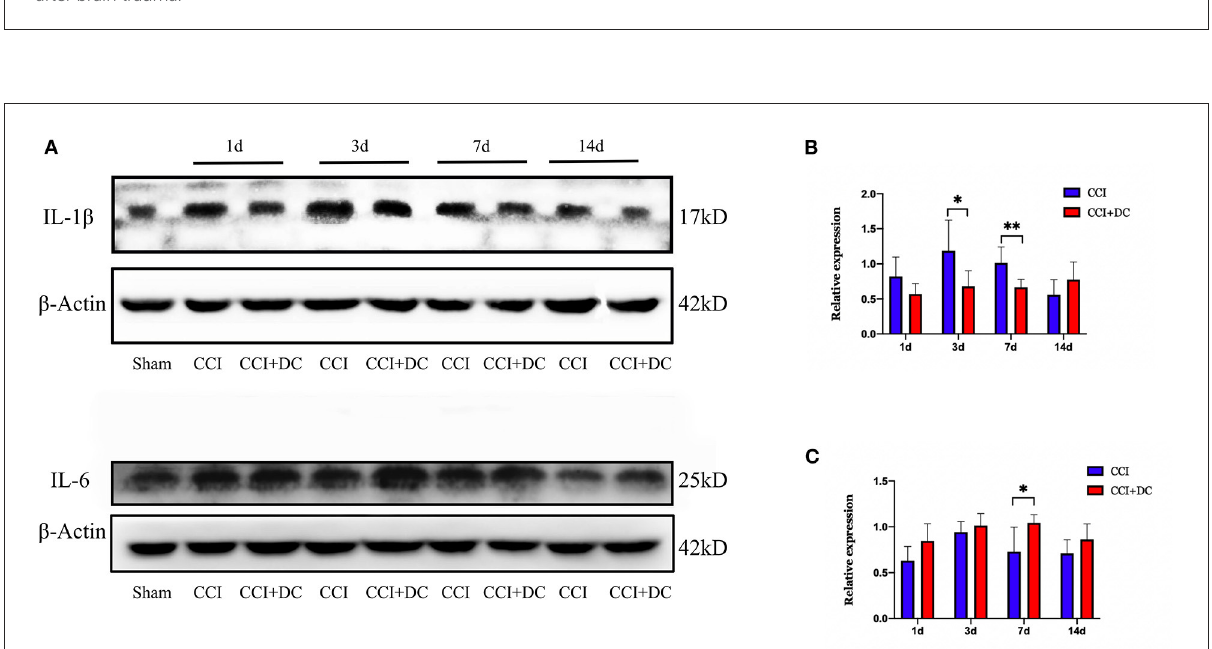
FIGURE8 Changes in the expression of inflammatory factors. (A) Changes in the expression of inflammatory factors at 24h, 3 d, and 7 d after brain trauma. (B) Expression levels of inflammatory factors in different groups of mice at 24h after brain trauma. (C) Different groups of mice The expression level of inflammatory factors on the 3rd day after brain injury. (D) Expression levels of 7D inflammatory factors in mice in different groups of D after brain trauma.